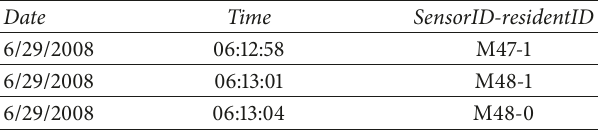
Table 2: Sample of sensor data log file. Table 3: Ranking of the connected rooms associated with an example of normal movements and